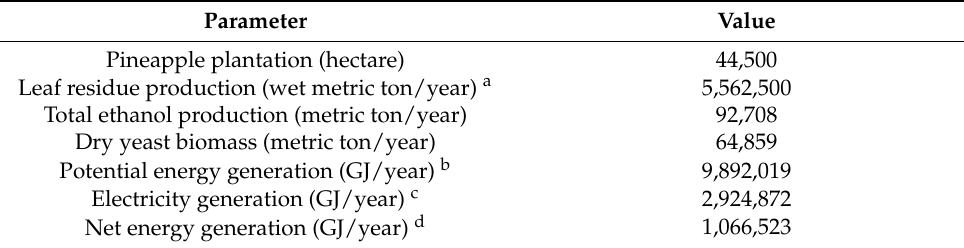
Table 3. Ethanol, fibrous material, and protein production of the studied biorefining process in Costa